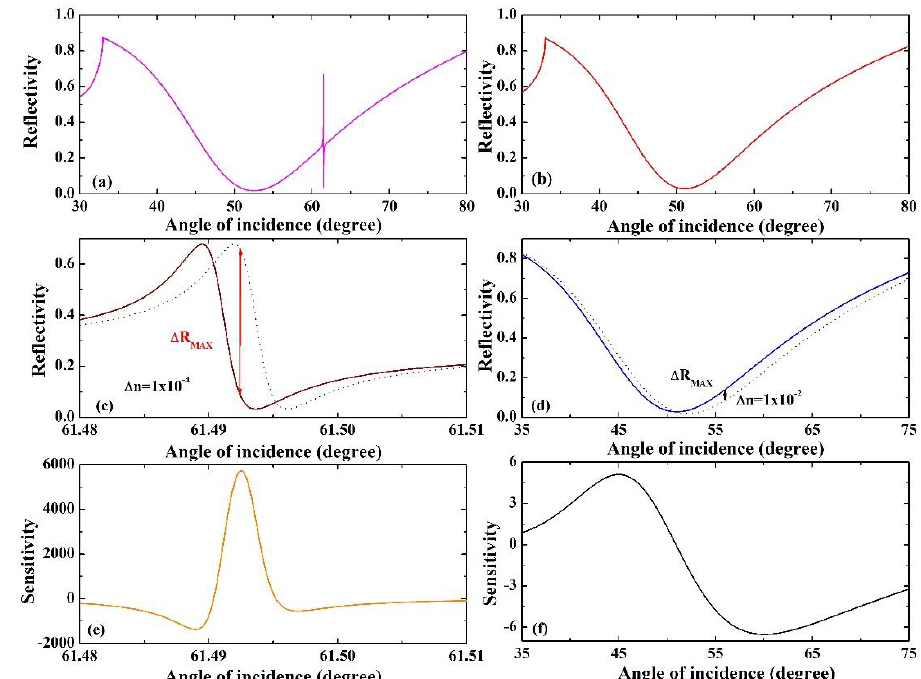
Figure 5. ( a ) Sharp resonance arising from the coupling between SEP mode and WGM for λ = 532 nm, d 1 = 35 nm, d 2 = 300 nm, d 3 = 62 nm and n s = 1.327. ( b ) Traditional SEP sensor for λ = 532 nm, d 1 = 35 nm and n s = 1.327. ( c , d ) The shift of the Fano-type resonance for the different coupling mode and conventional SEP sensor, caused by the different refractive index of sensing medium with Δ n s = 1 × 10 − 4 and Δ n s = 1 × 10 − 2 . ( e , f ) The corresponding sensitivity varying with the incident angle.